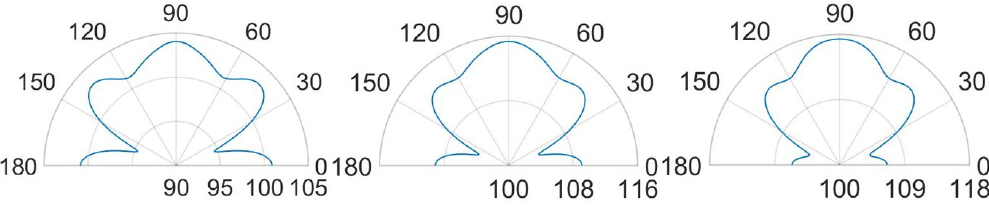
Figure 24. SPL polar plot (dB) at the performing fundamental frequency of 93.0 kHz (3 V bias), at 3.5 cm in the y(90 ◦ )–z(0 ◦ ) plane: (a) ( left ), (b) ( center ), (c) ( right